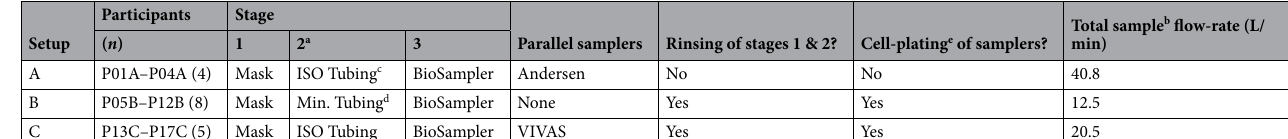
Table 1. Different configurations of experimental setup used to collect droplets and bioaerosols emitted during breathing, speaking and coughing. a For all three setups, the inlet elbow of the BioSampler was considered as part of Stage 2 (including rinse samples) given its capture of smaller droplets ( (cid:31) 10 µ m ). b The combined flow-rates of parallel bioaerosol samplers are reported as nominal flow rates recommended by the manufacturers. Where possible, actual flow rates were measured with a bubble or DryCal flow-meter and reported in the Supplementary Data Tables. c The assembly required to split the sample flow between the bioaerosol samplers consisted of a 22 mm ISO tee to 0.75 ′′ tubing (4 long) to the ACI’s inlet or to 0.75 long) to the BioSampler’s elbow inlet. d Minimal plumbing components were used to adapt the mask assembly to the BioSampler inlet. For P05B–P08B, a 3/4 long) was used, while for P09B–P12B a 3D printed adapter (22 mm female ISO tapered to 1/2 ′′ tubing (1/2 long) was used. e Trial runs demonstrated that the Vero cells at room temperature in VTM after sampling with the BioSampler were found to be viable for at least 24 h after sampling. For the Biosampler collection vessels or VIVAS Petri dishes with pre-plated cells (i.e. utilized in Setups B and C), HEPES was added to the VTM at a final concentration of 20